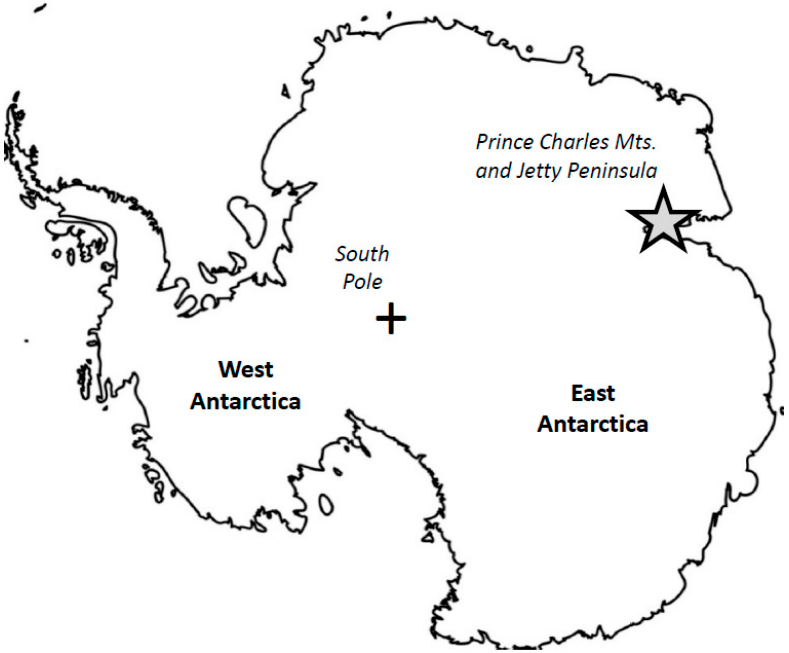
Figure 1. Schematic map of Antarctica showing the position of the Prince Charles Mountains and Jetty Peninsula (asterix).